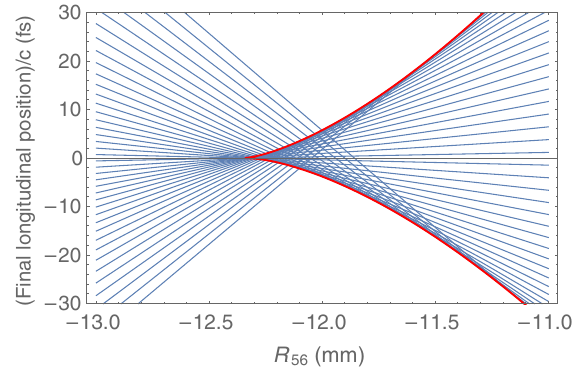
FIG. 6. Caustic expression [Eq. (8)] shown in red overlayed on electron trajectories, showing where in z current spikes can be anticipated for a given R 56 value, for a 4 dipole chicane where T − 3 = 2 R U 2 R 566 ¼ 56 and 5666 ¼ 56